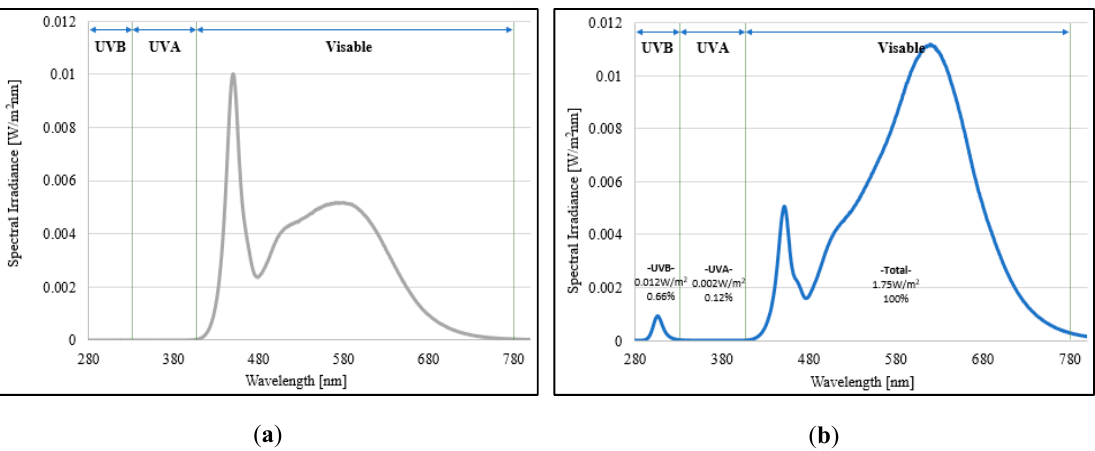
Figure 6. Spectral distribution of commercial and proposed general lighting. ( a ) General (normal) lighting; ( b ) proposed lighting (UV and visible).